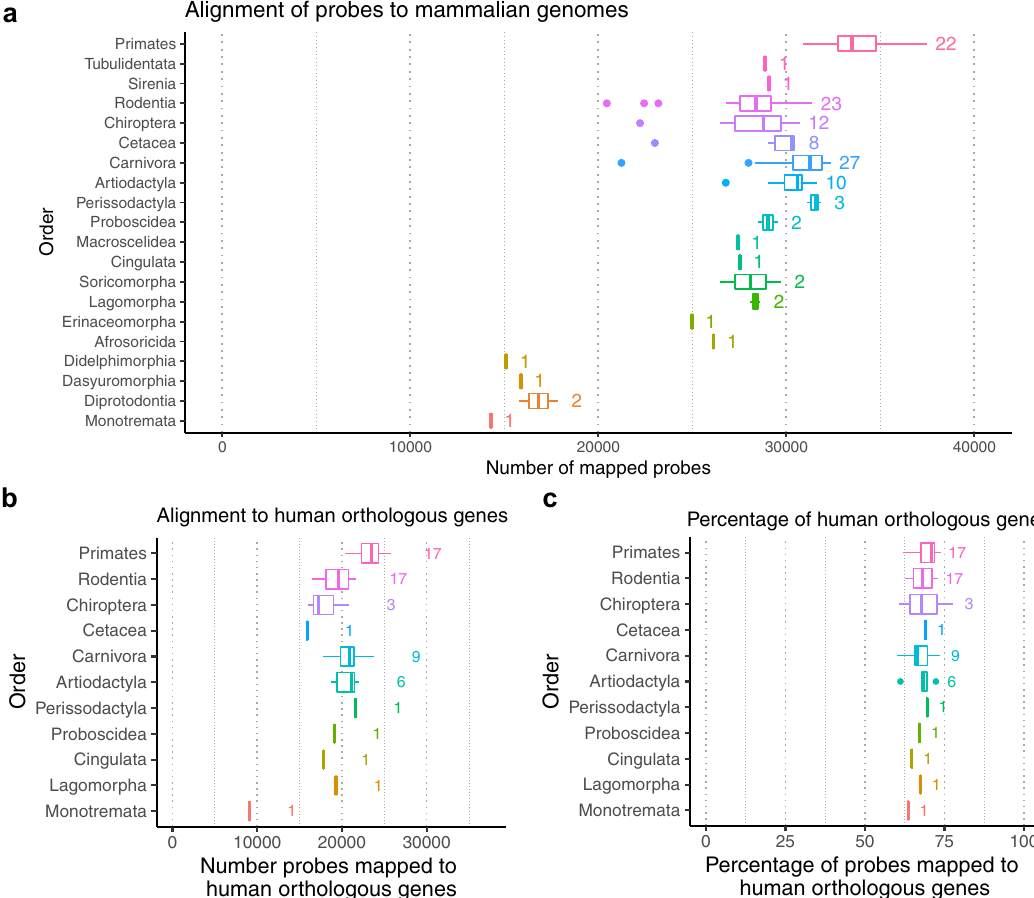
Fig. 2 CpG and gene coverage of probes on the mammalian methylation array across different phylogenetic orders. a Probe localization based on the QuasR package 43 . The rows correspond to different phylogenetic orders. The phylogenetic orders are ordered based on the phylogenetic tree and increasing distance to human. The x axis reports the median number of mapped probes across species from the given phylogenetic order. The number to the right of each boxplot reports the number of species per order, e.g., n = 22 primate species. b The number of probes mapped to human orthologous genes for the subset of genomes in the Ensembl database ( x axis). n = 17 genomes were used for primates. c Percentage of the probes associated with human orthologous genes among mapped probes for the species in b . The boxplot visualizes the median (vertical line in box) and upper and lower quartiles (25th and 75th percentile). The whiskers represent at most the 1.5*interquartile range of each order by extending to the most extreme data point that is no more than 1.5 times the interquartile range from the